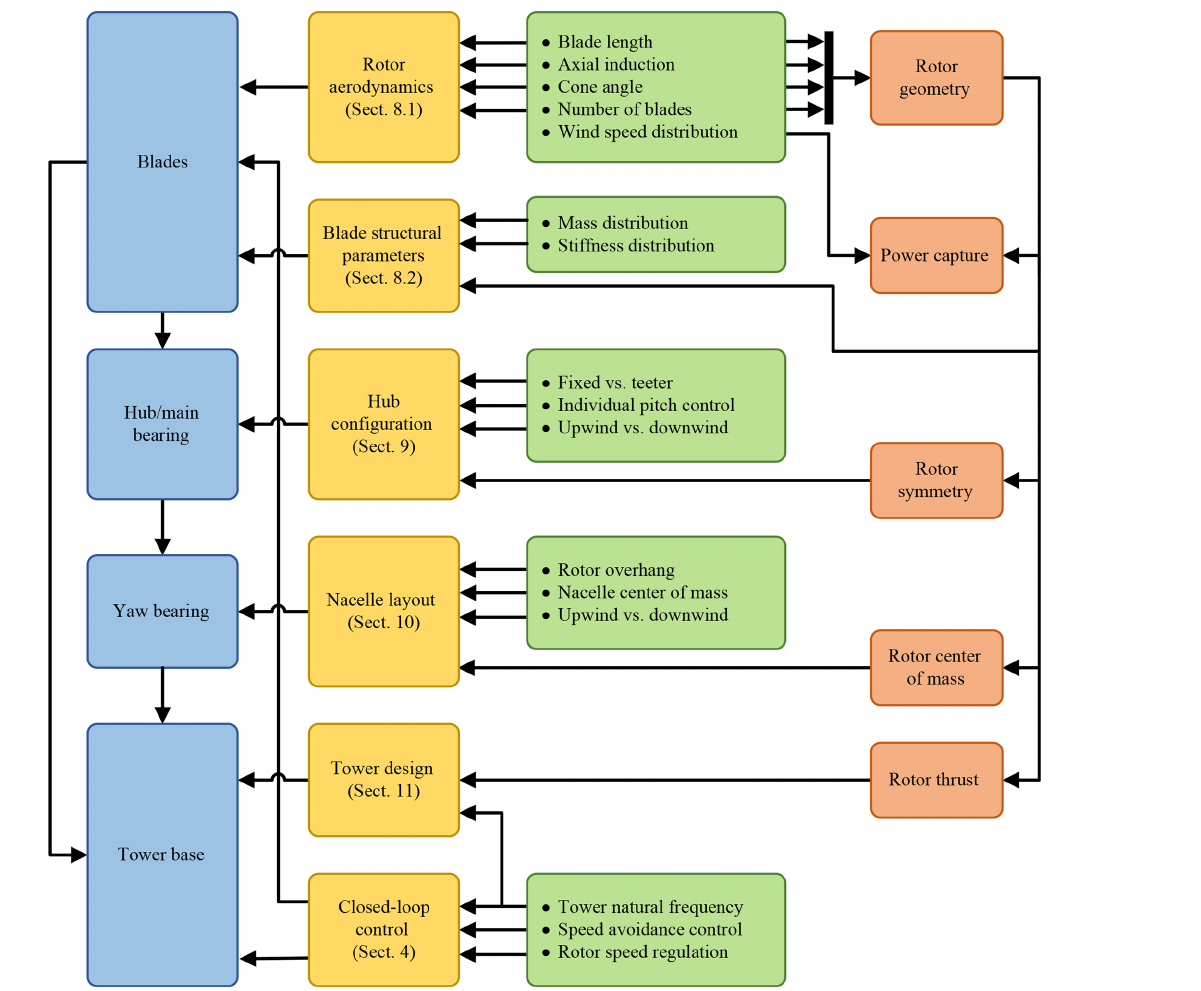
Figure 7. Overview of the design studies performed in this paper. The loads on each component (blue) transfer from the blades to the tower base as shown. Design studies (yellow) that affect each component are performed in Sects. 8–11 by altering the design parameters in green. Rotor design parameters (orange) affect all aspects of turbine